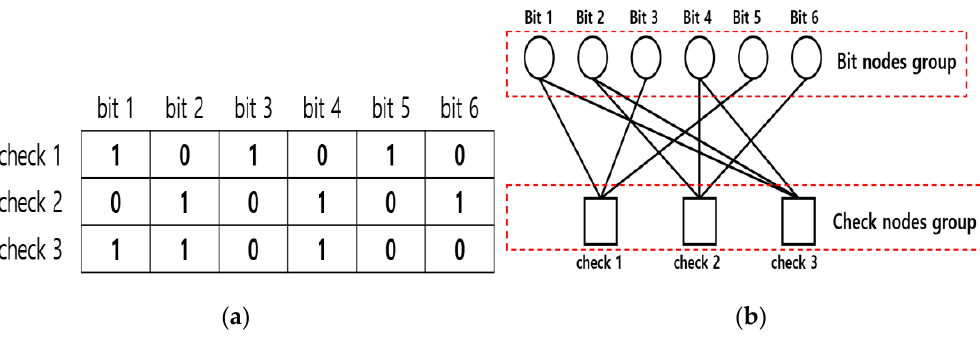
Figure 4. Representation of an LDPC code using ( a ) a parity-check matrix H and ( b ) Tanner graph.